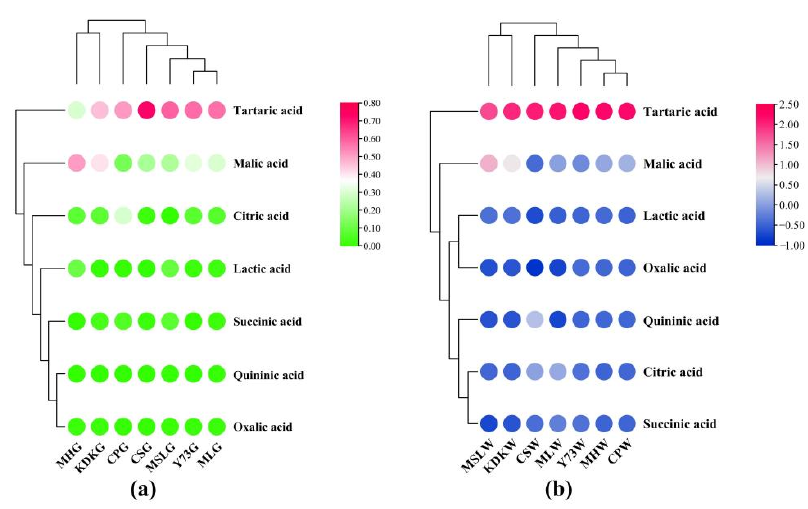
Figure 2. The clustering analysis of seven organic acids in seven grape cultivars ( a ) and corresponding wines ( b ). If the color of the circle tends towards red, the content of organic acid is higher. Samples’ full names are as follows: MSL (Marselan), Y73 (Yan 73), MH (Muscat Hamburg), KDK (Kadarka), ML (Merlot), CS (Cabernet Sauvignon) and CP (Crimpose). Furthermore, G represents “grape” and W represents “wine”.